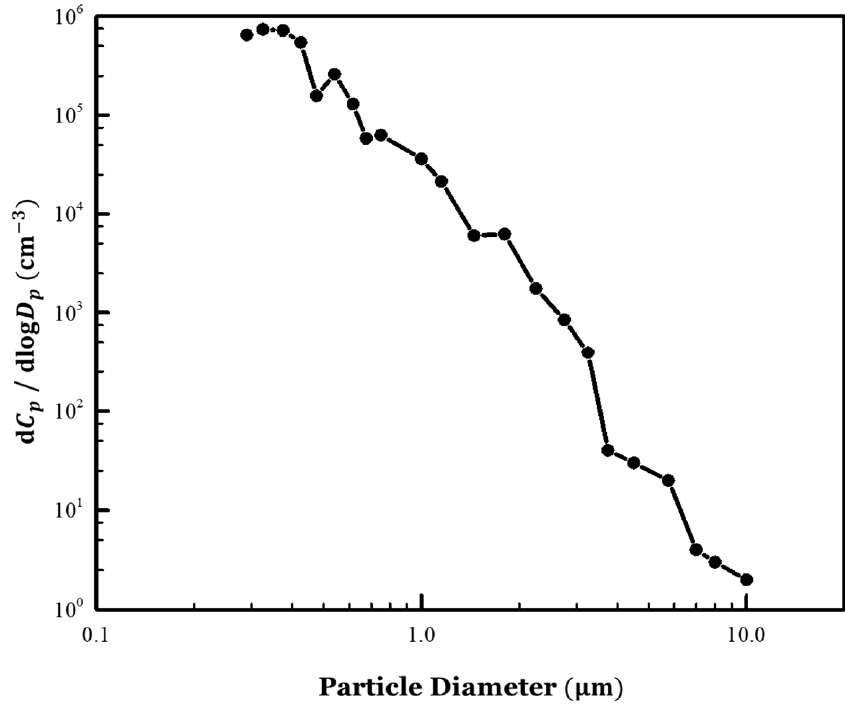
Figure 4. Particle size distribution of the NaCl aerosol injected into the classroom.